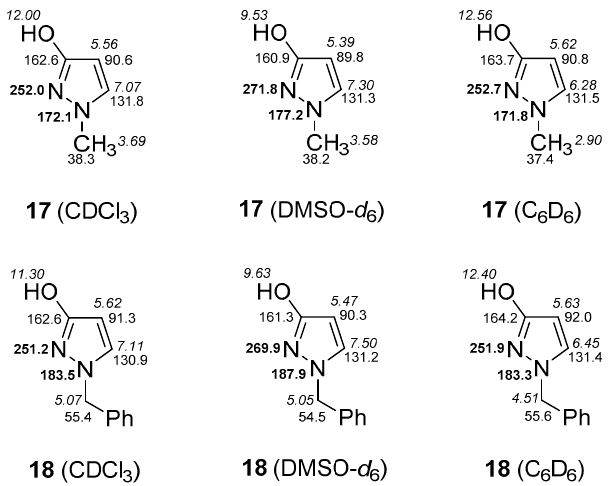
Figure 8. Crucial 1 H (in italics), 13 C, and 15 N (in bold) NMR chemical shifts of 1-methyl-1 H -pyrazol-3- ol ( 17 ) and 1-benzyl-1 H -pyrazol-3-ol ( 18 ) in CDCl 3 , DMSO- d 6 , and C 6 D 6 solution. 3. Experimental Section